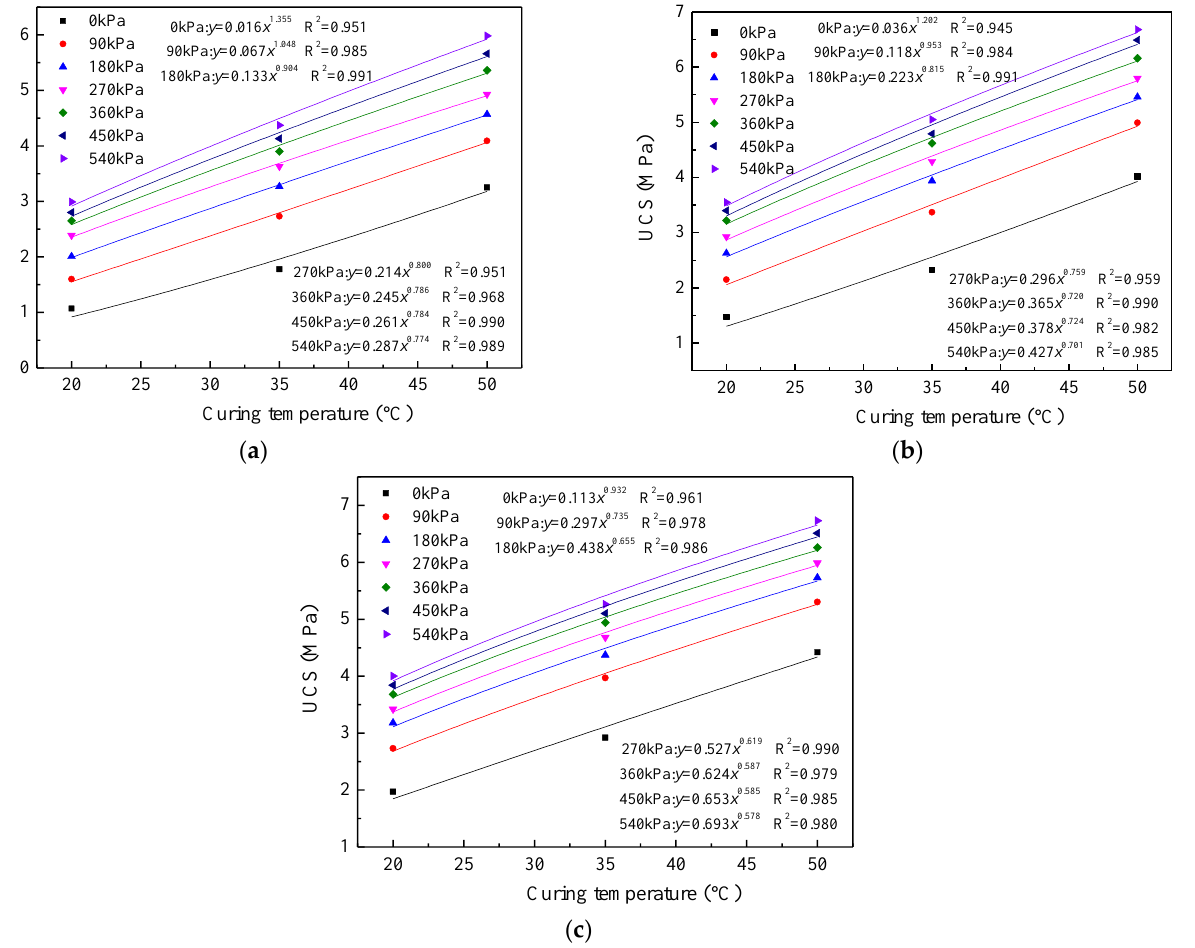
Figure 4. Relationship between UCS and curing temperature with different curing stress: ( a ) 7 d; ( b ) 14 d; ( c ) 28 d. Table 3. The evolution rule of the UCS growth rate for the